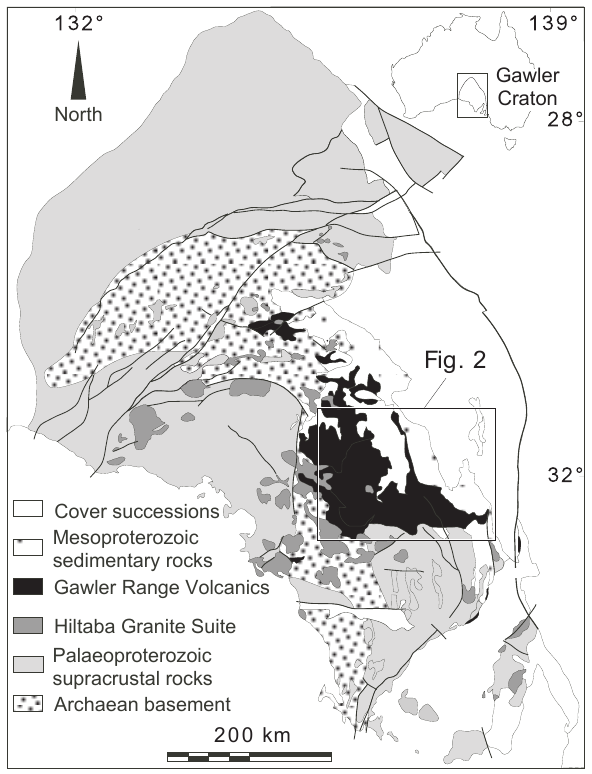
Fig. 1. Simplified geological map of the Gawler Figure 1. Pankhurst et al.,